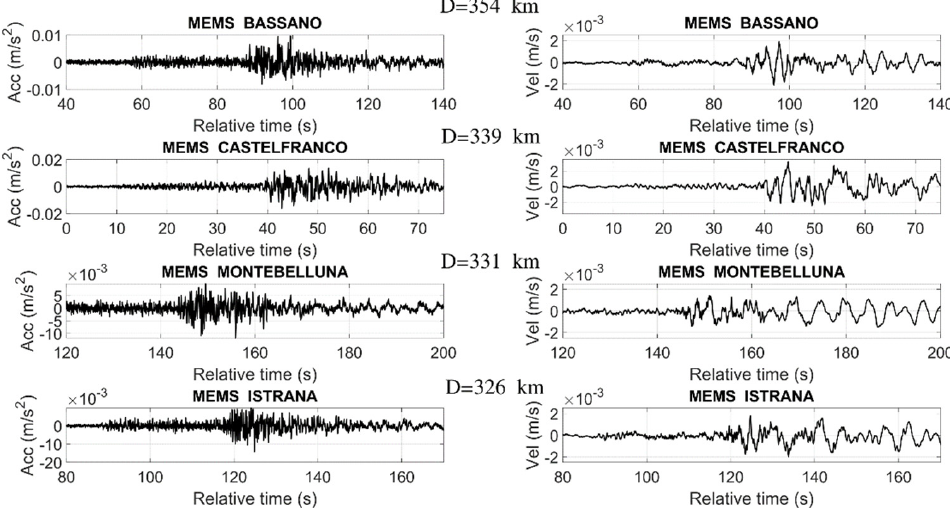
Figure 5. Acceleration time histories of the M w 6.3 Petrinja earthquake that took place on 29 December 2020, recorded by the MEMS sensor installed in northern Italy (D indicates the epicentral distances).